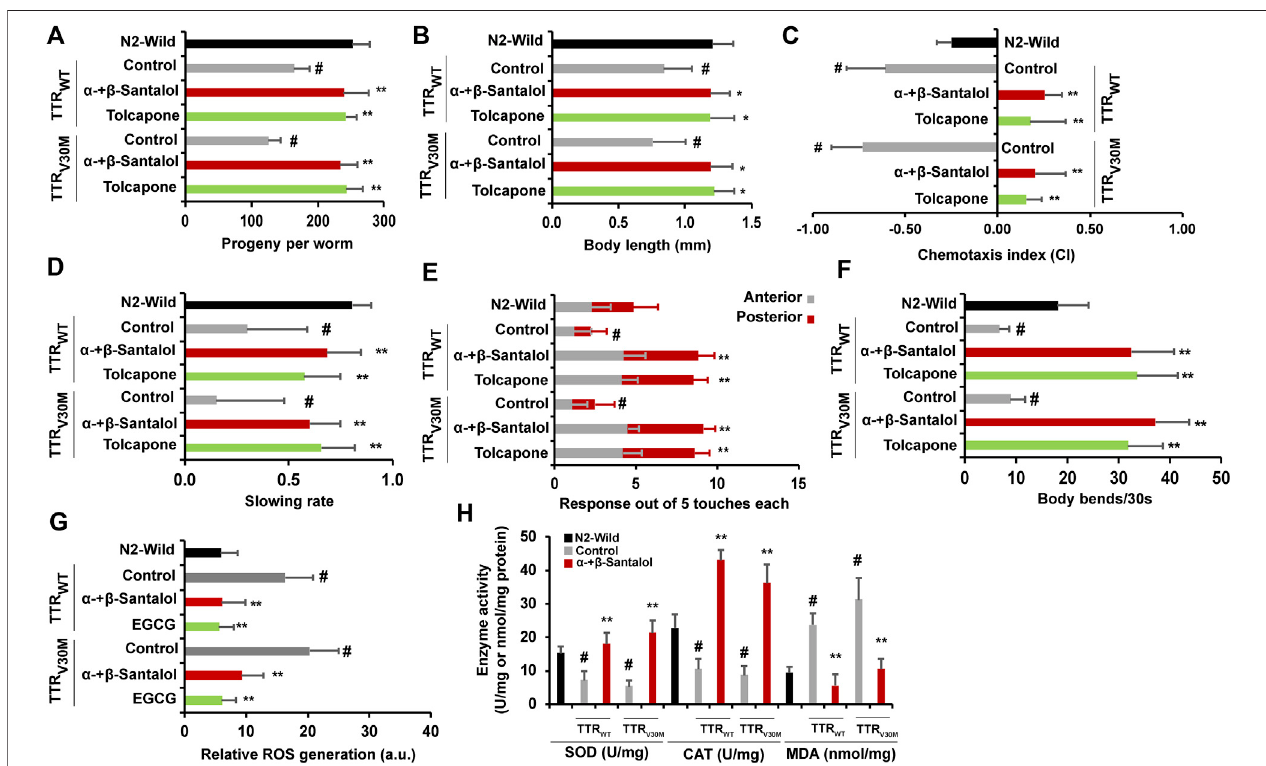
FIGURE 7 | Santalol isomers confer favorable healthspan bene fi ts on C. elegans expressing TTR proteins. Synergistic effect of α -+ β -santalol on (A) reproduction, (B) development, (C) chemotaxis, (D) food sensing, (E) touch response, (F) body bends, (G) ROS levels, and (H) antioxidant enzymes and MDA levels in TTR WT and TTR V30M worms. Data are presented as mean ± SD; # p < 0.01 vs. wild-type; * p < 0.05, ** p < 0.01 vs.